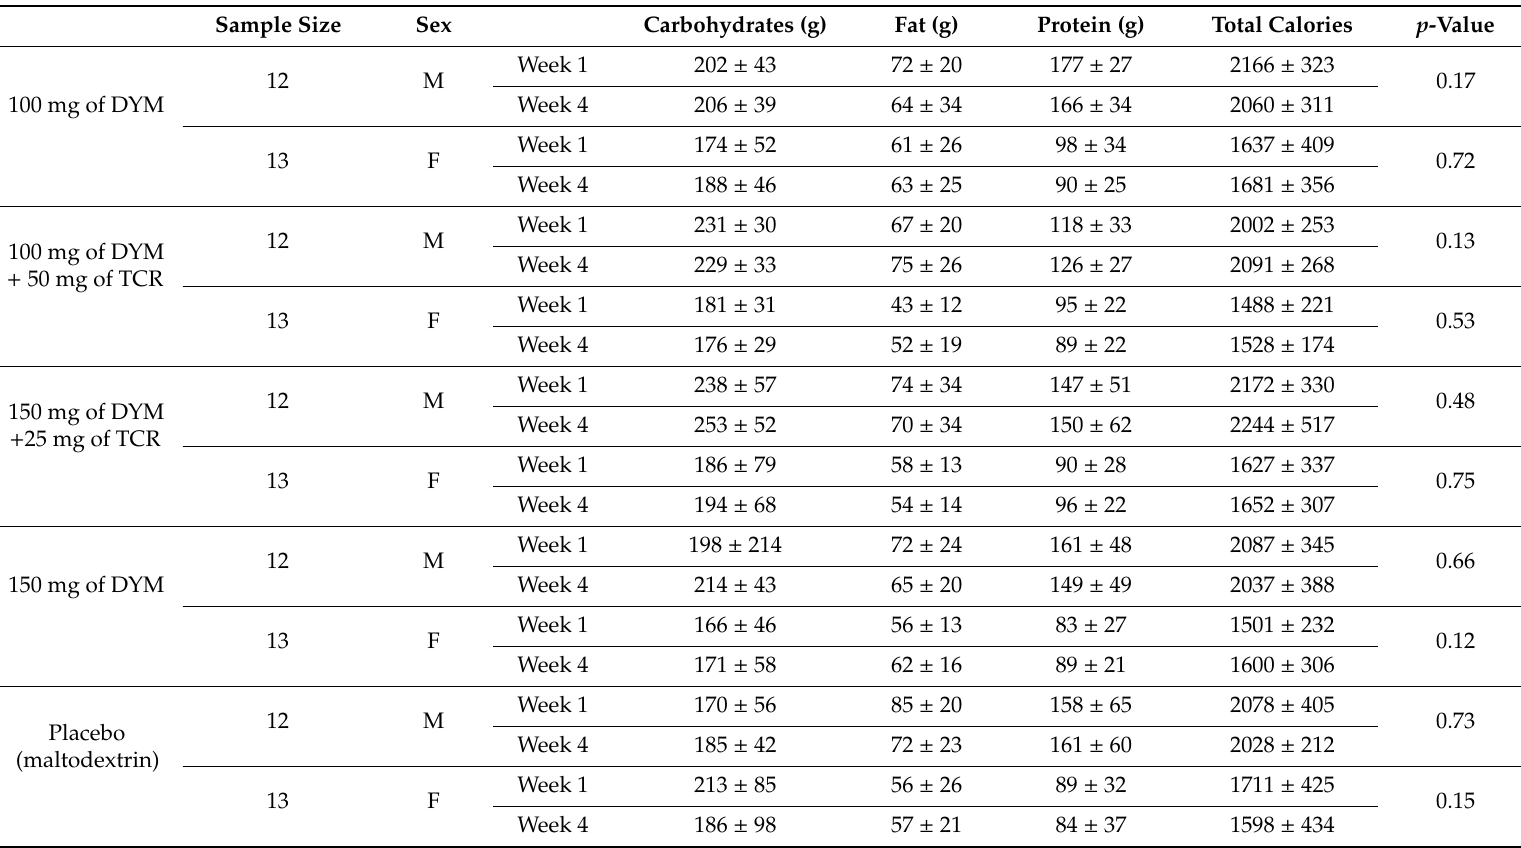
Table 8. Macronutrient intakes and total calories at week one and week four for all participants. Values are mean ±